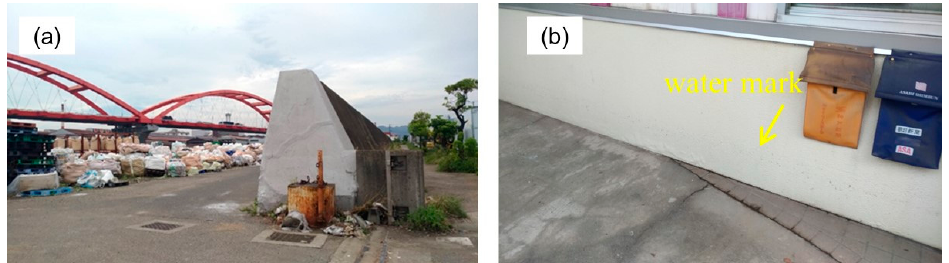
Figure 6. Photographs taken by the authors at Mikageishi town. ( a ) Coastal levee and gate at the entrance of the port storage zone; ( b ) Survey Point M1 (watermark is indicated by a yellow allow).